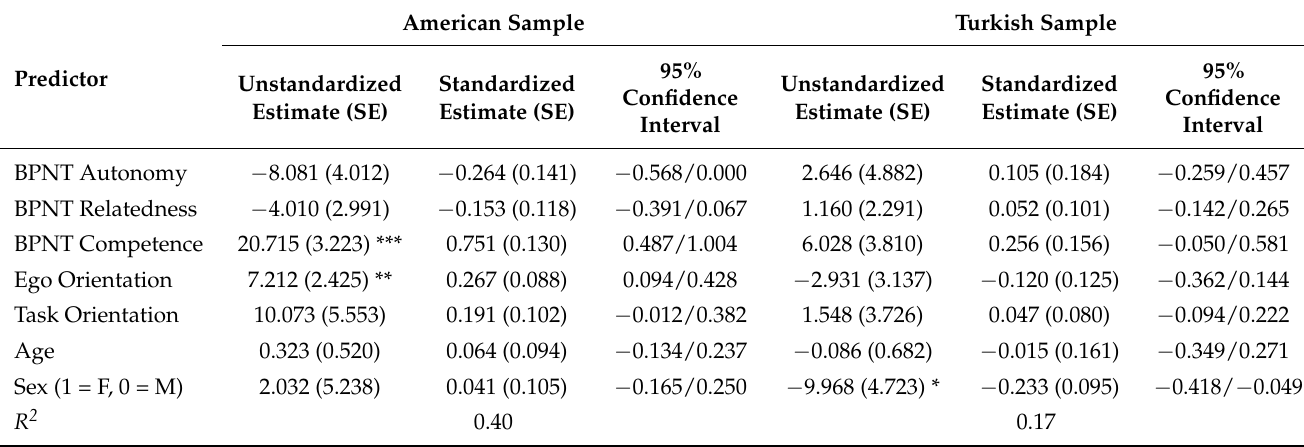
Table 3. Results from multi-group analysis: Moderating role of cultural